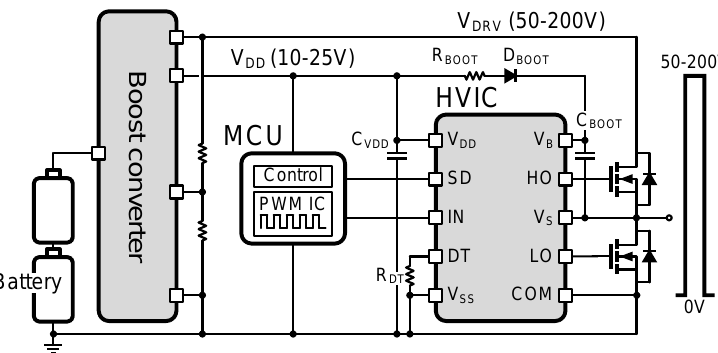
Figure 1. System block diagram of the high-voltage gate